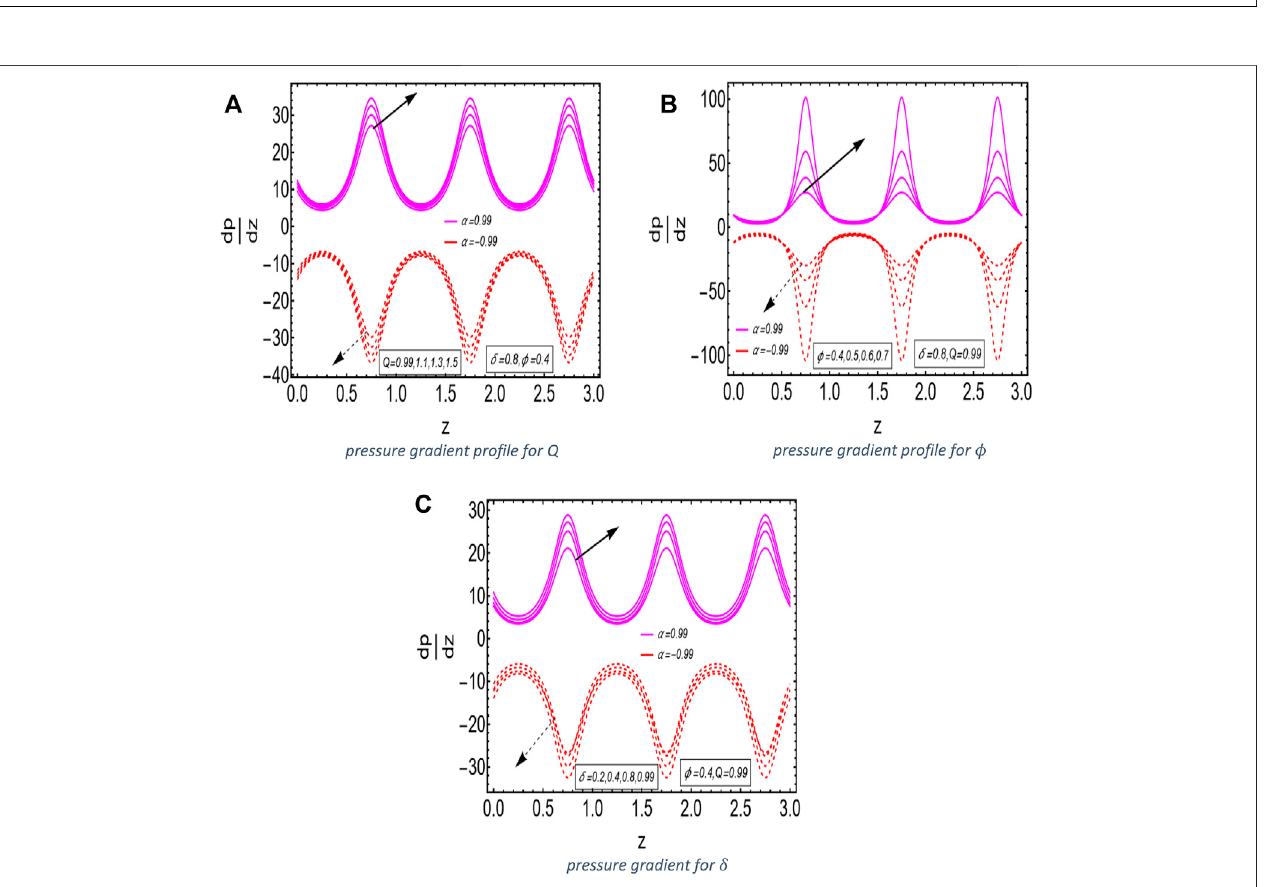
FIGURE 4 | (A) Pressure gradient pro fi le for Q. (B) Pressure gradient pro fi le for ϕ . (C) Pressure gradient for δ .